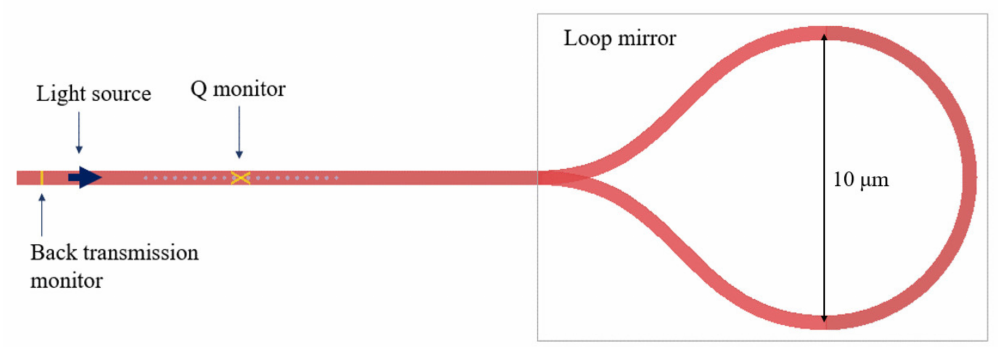
Figure 3. 1D PhC with inserted end loop-mirror (ELM) structure at one end to increase its Q value and its simulation